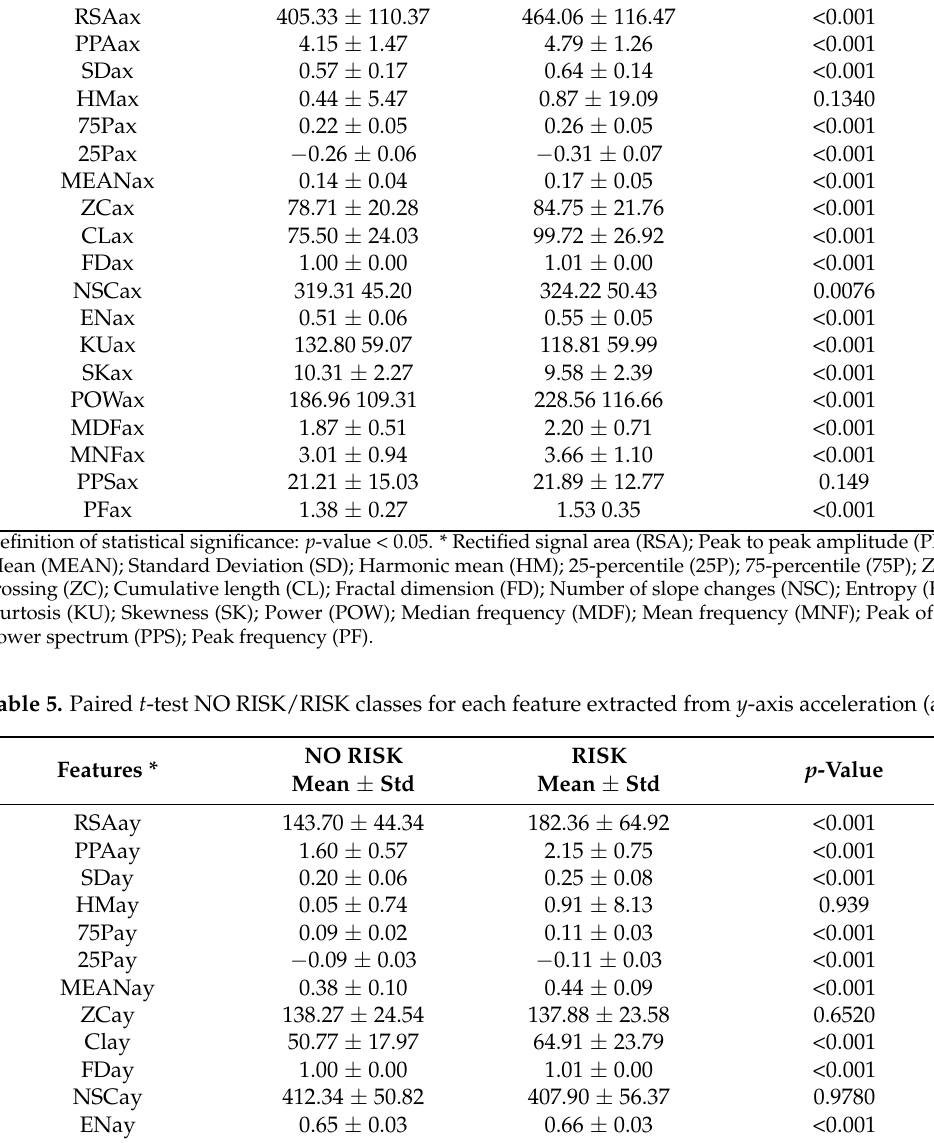
Table 4. Paired t -test NO RISK/RISK classes for each feature extracted from x -axis acceleration (ax). Features *